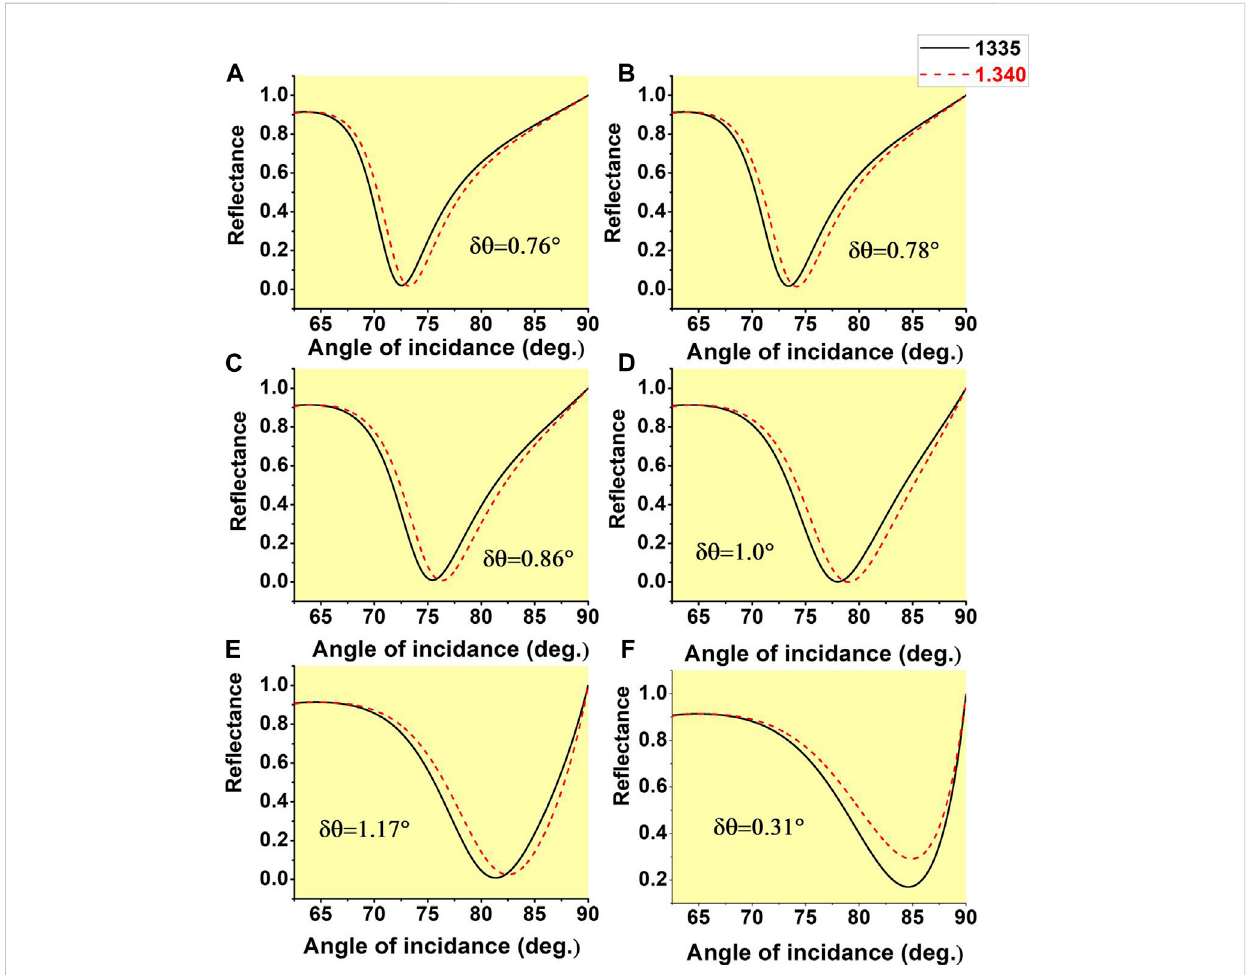
FIGURE 5 The variation of the re fl ectance with the angle of the incidence of the prism for the two RI of the analyte 1.335 and 1.340 when the thickness of the adhesion layer of MgO is considered as 10 nm, while the number of BP layers on Ag are (A) 1 layer (B) 2 layers (C) 4 layers (D) 6 layers (E) 8 layers (F) 10